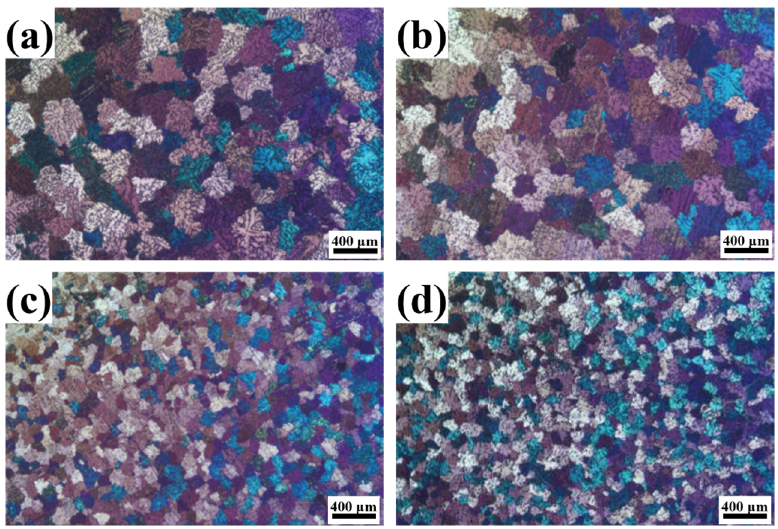
Figure 3. Color metallography of as-cast AZ31 alloy with different amounts of CaMgSn addition (mass fraction): ( a ) no addition; ( b ) 0.21%; ( c ) 0.45%; ( d ) 0.75%.